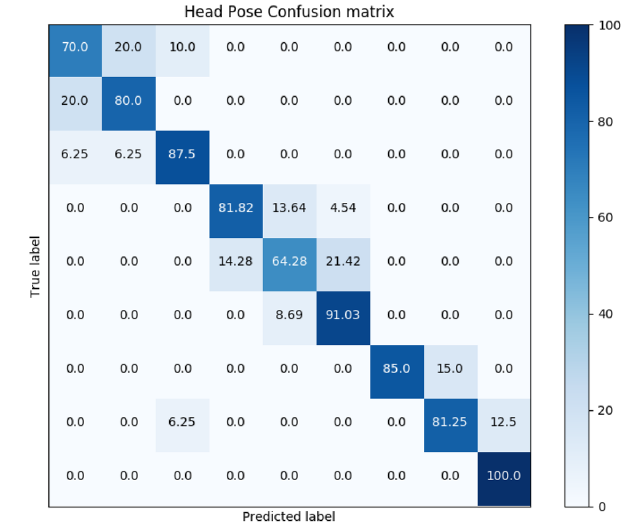
Figure 10. Confusion Matrix calculated for Head Pose validation